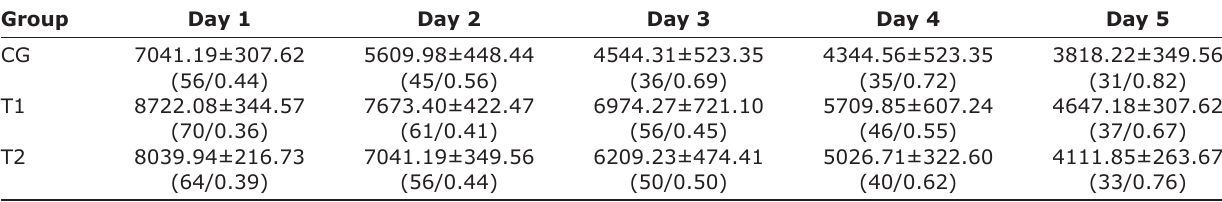
Table-3: Effect of L-arginine addition in skim milk extender chilled for a 5-day evaluation on the number of motile goat spermatozoa.